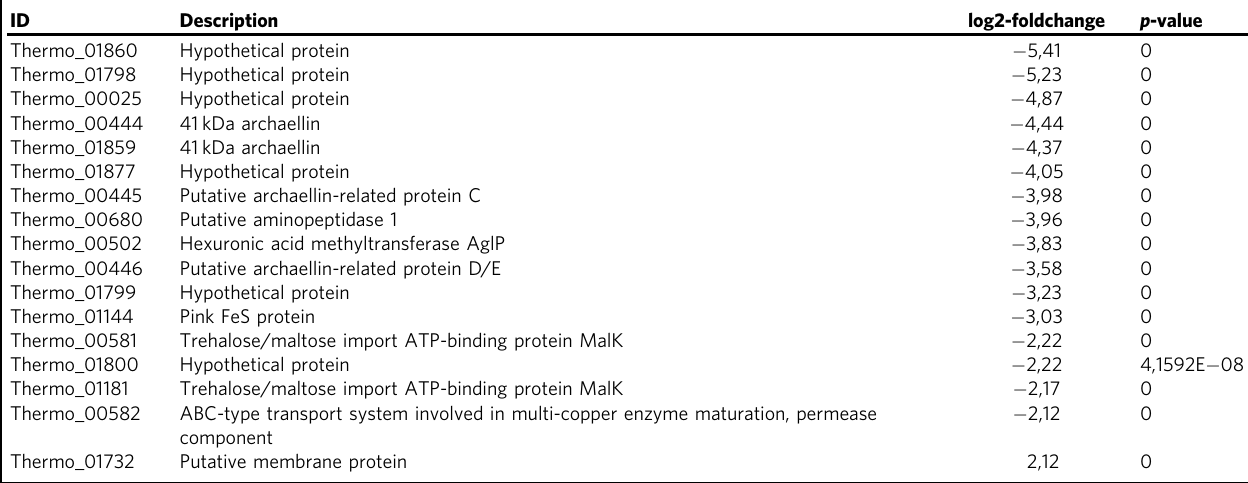
Table 2 Differentially expressed genes of Ca . Schef fl eriplasma hospitalis in pure culture in comparison to Ca . Schef fl eriplasma hospitalis in co-culture with Ca . Micrarchaeum harzensis. The table indicates the gene ID, the description of the expressed protein, the log2-fold change and the p -value (<0.01; two-tailed Wald test, Bonferroni